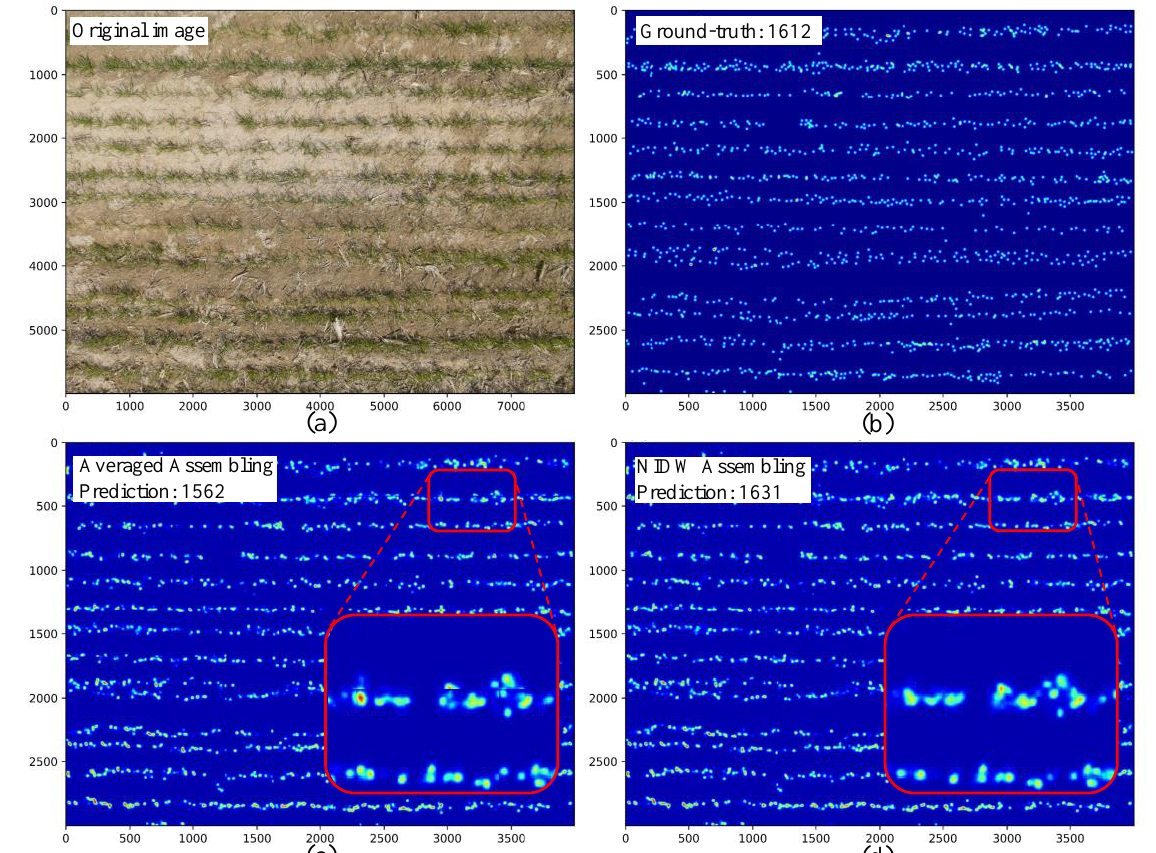
Figure 7. Heatmap assembling results in different assembling techniques. ( a ) A full image in the validation dataset. ( b ) The heatmap from annotated points. ( c ) The assembled heatmap using the averaging technique with the predicted heatmap. ( d ) The assembled heatmap using the NIDW technique with the predicted